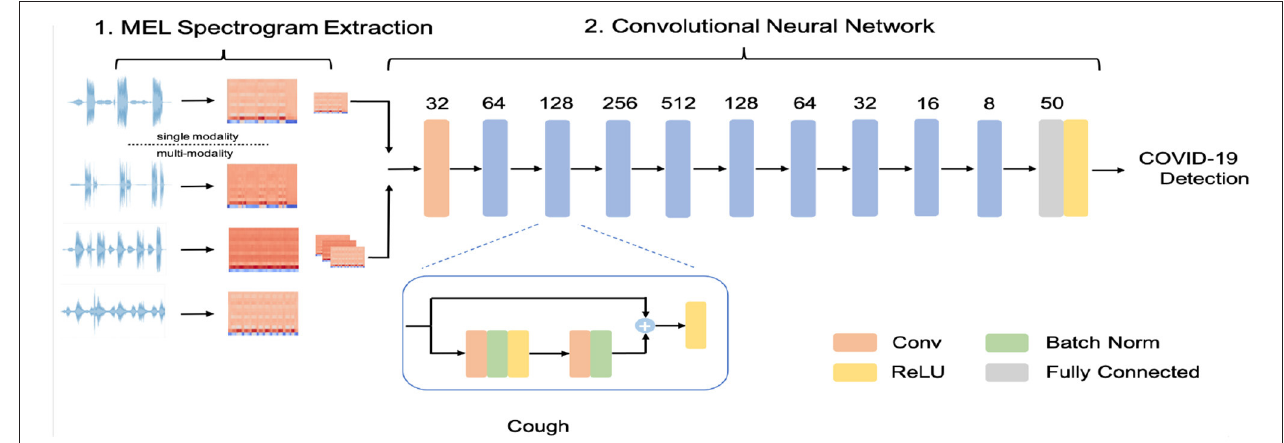
FIGURE 1 | A schematic of the COVID-19 Identification ResNet, (CIdeR). The figure shows a blow-up of a residual block, consisting of convolutional, batch normalization, and Rectified Linear Unit (ReLU) layers.